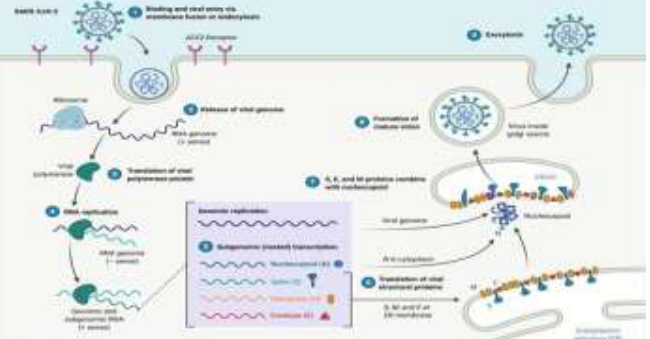
Fig. 3. Mechanism of action of anti - SARS CoV - 2 scFv IgY - antibodies. This mechanism blocks the attachment of virus to the host cell receptors (ACE2). Structural comparison between both mammalian antibody (IgG) and chicken egg - yolk antibody (IgY). (the figure was made using